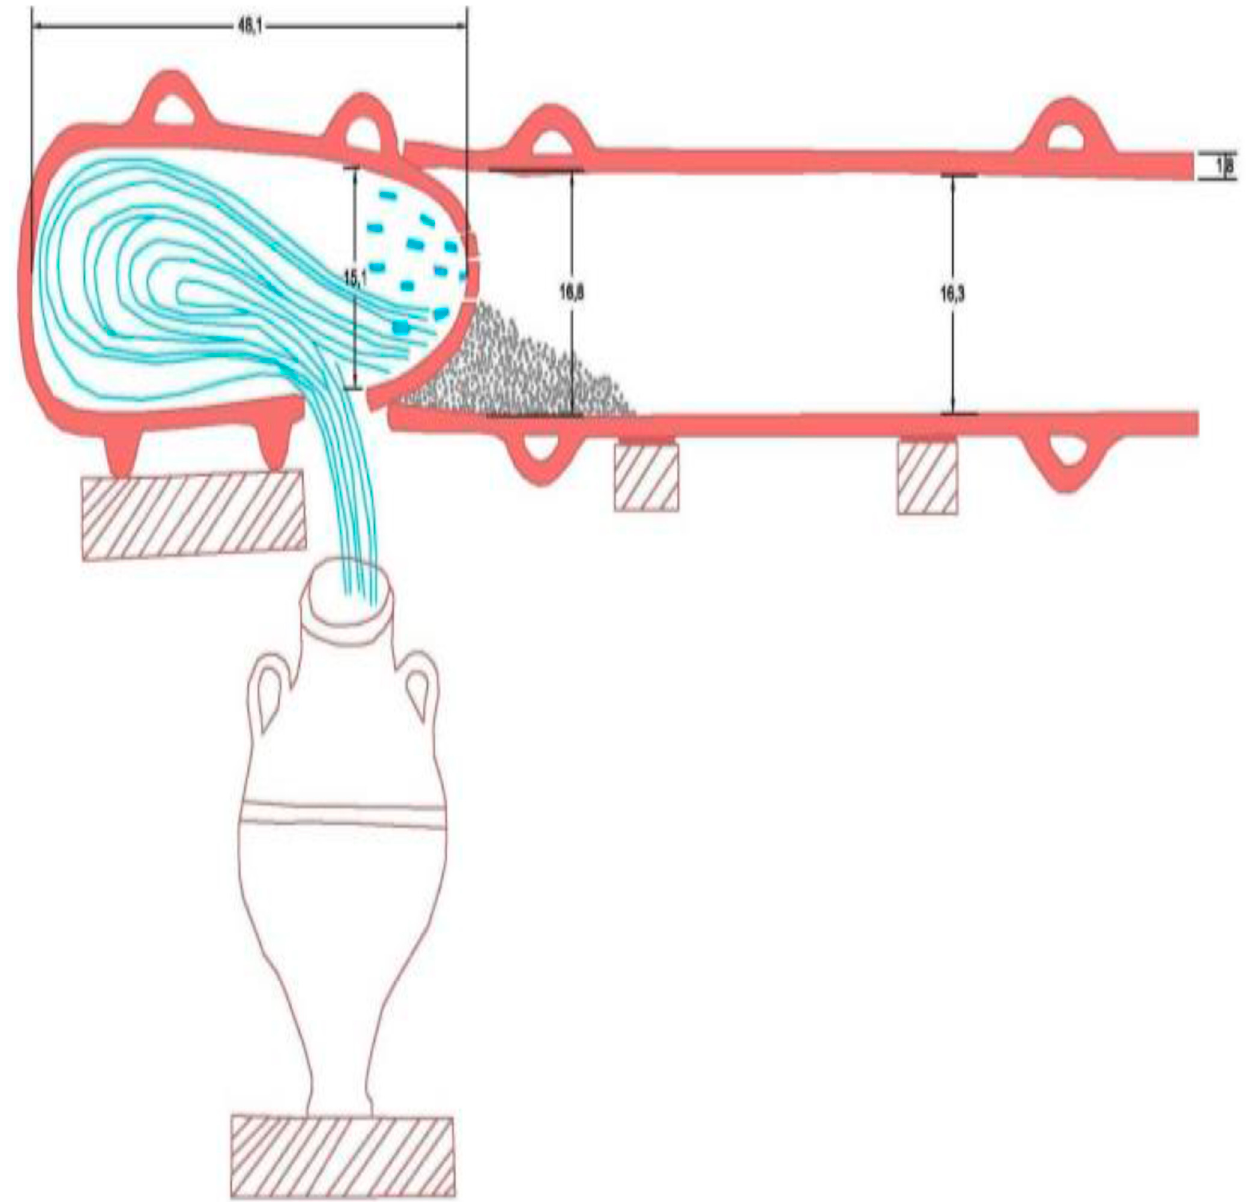
Figure 1. Water ceramic filter (adapted from [21]).